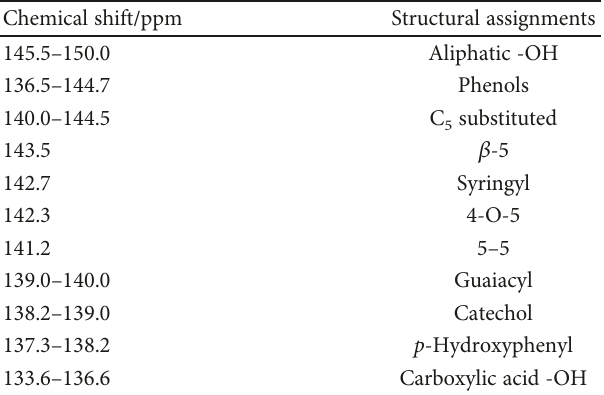
Table 5: Assignments of signals in 31 P NMR spectrum to hydroxyl groups in lignin [29,